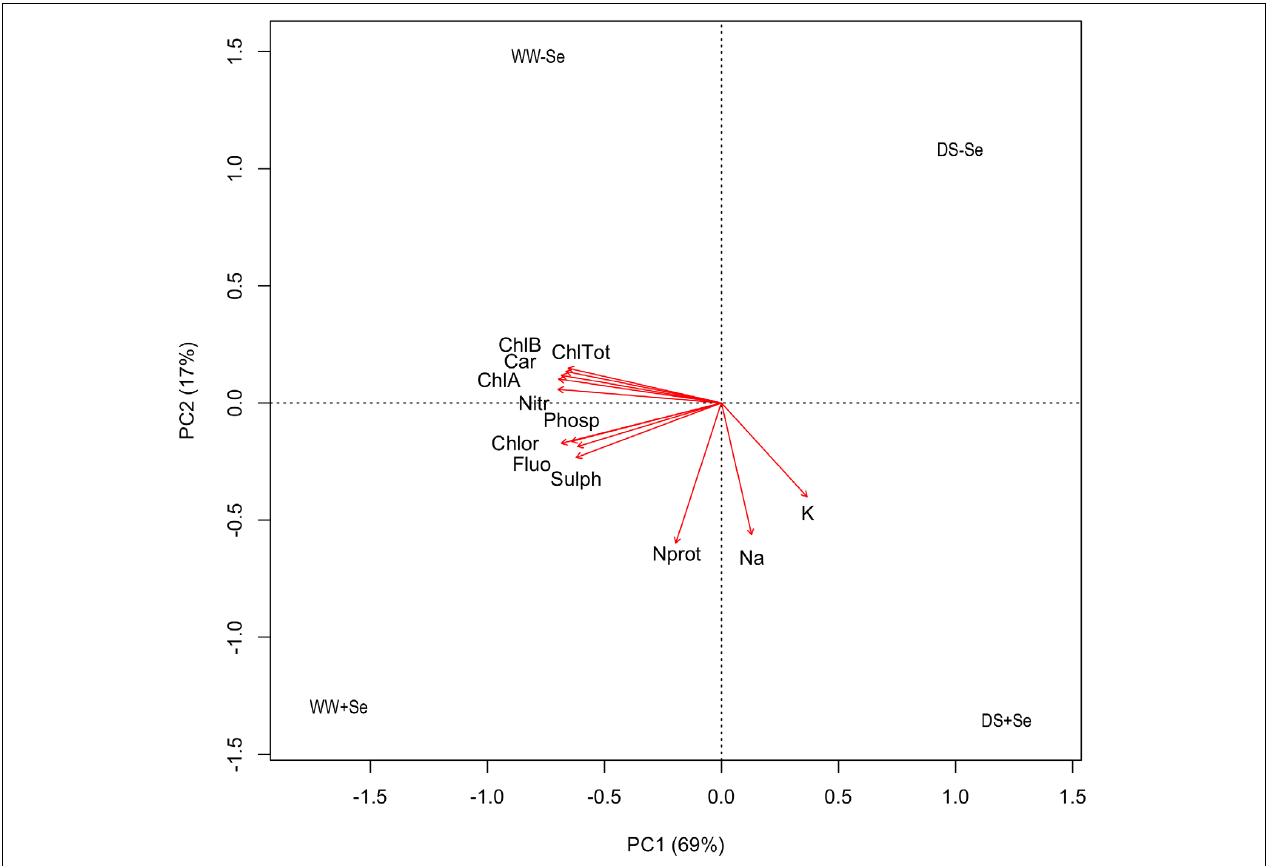
FIGURE 2 | PCA on correlation matrix for the concentration of several compounds in aerial parts (DW). Sodium (Na); potassium (K); proteic nitrogen (Nprot); chlorophyll A (ChlA); chlorophyll B (ChlB); Total chlorophyll (TotChl); carotenoids (Car); nitrates (Nitr); fluorides (Fluo); sulphates (Sulph); phosphates (Phosph) and chlorides (Chlor); (WW–Se) normal irrigation without selenium treatment, (DS–Se) drought stress without Se treatment, (WW+Se) normal irrigation with Se treatment and (DS+Se) Se under drought stress conditions.